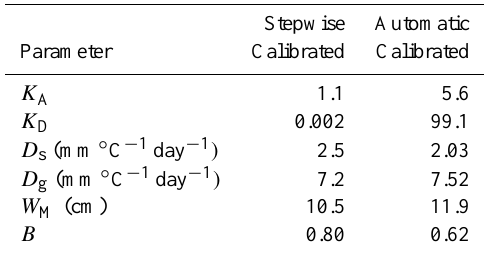
Table 4. Calibrated parameters by the stepwise and automatic meth- ods.